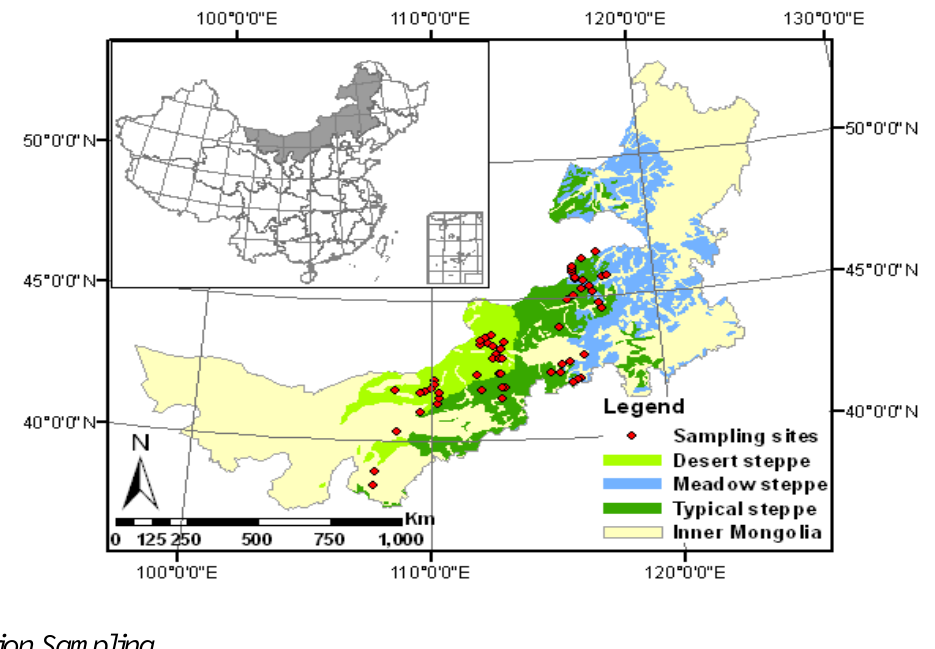
Figure 1. Spatial locations of 61 sampling sites in the study area overlaid on land